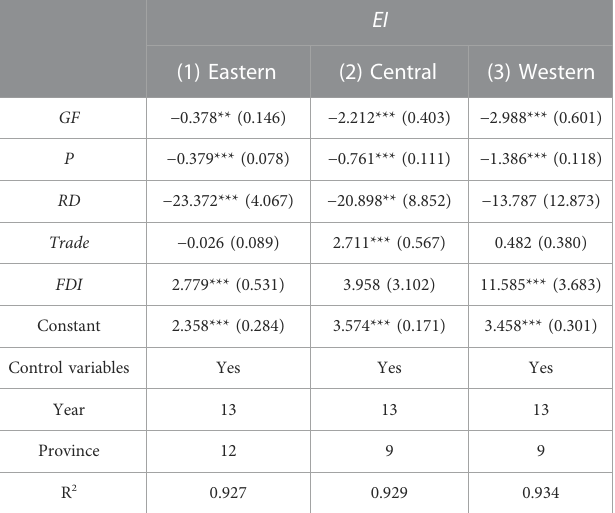
TABLE 5 Direct, indirect, and total effects of green fi nance impact on energy intensity. Variable